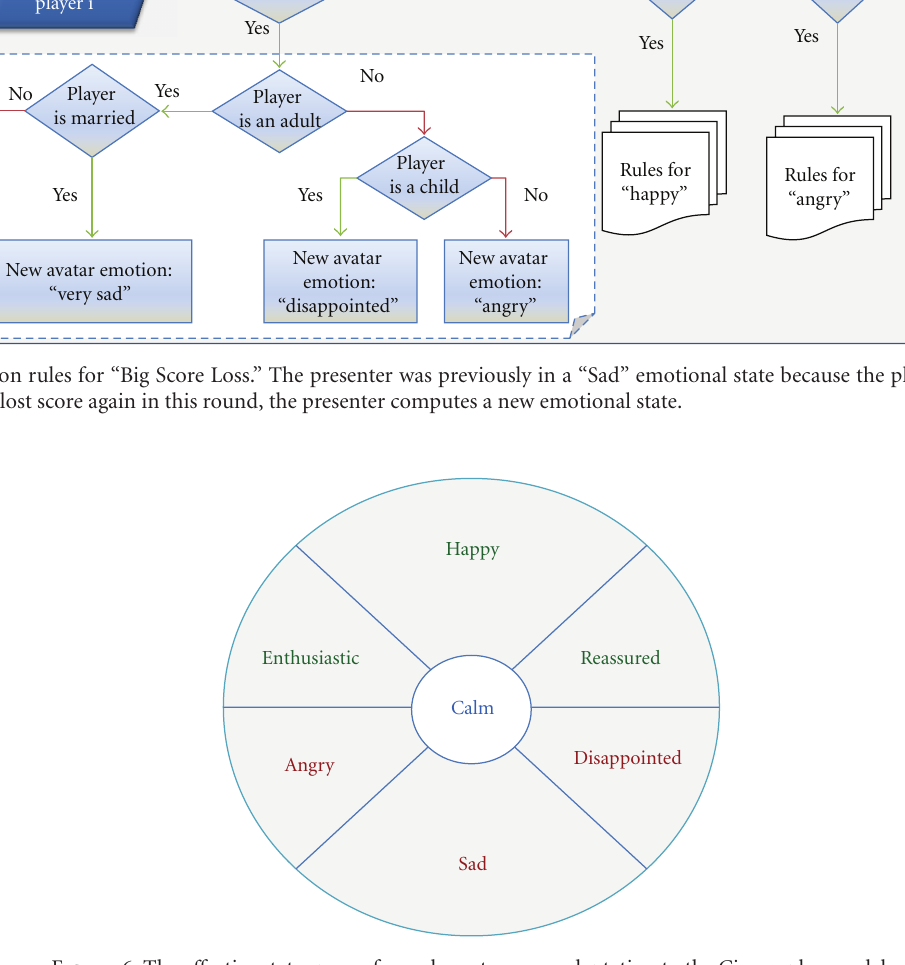
Figure 6: The a ff ective state space of our character as an adaptation to the Circumplex